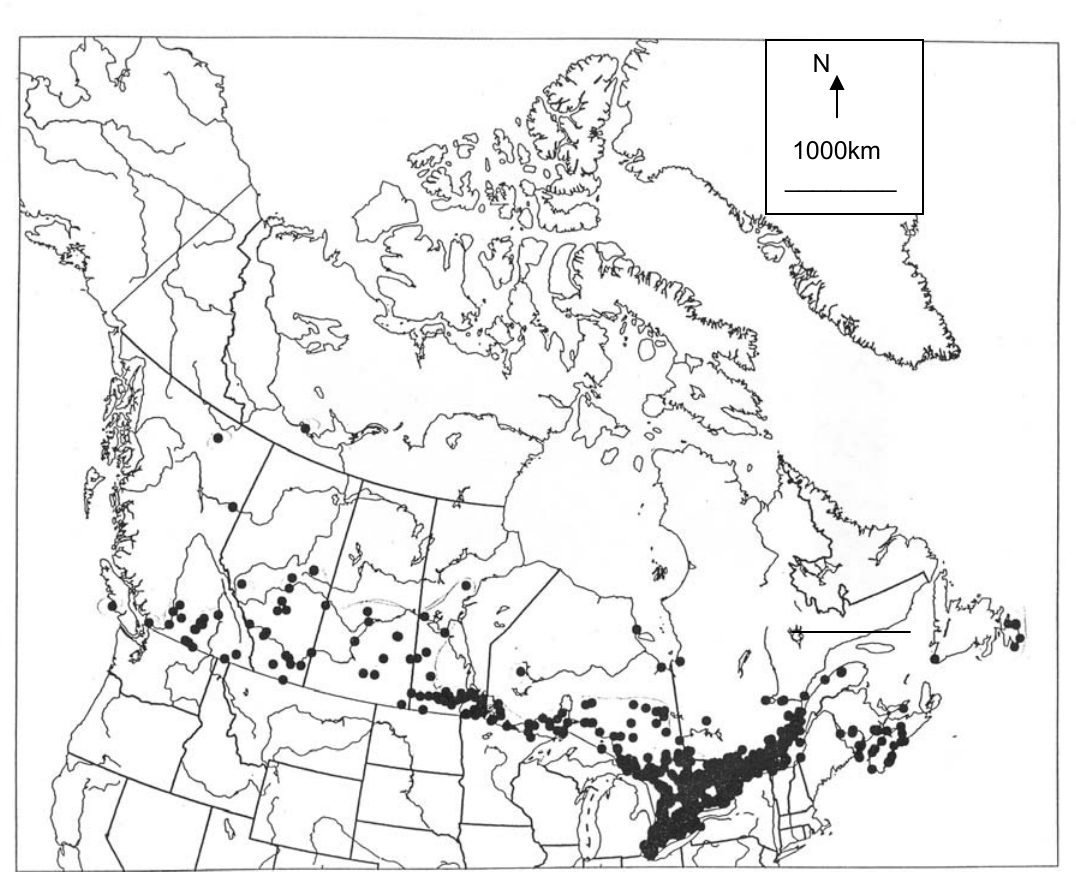
Figure 1. The distribution of the Monarch ( Danaus plexippus ) in Canada (Crolla and Lafontaine 1996